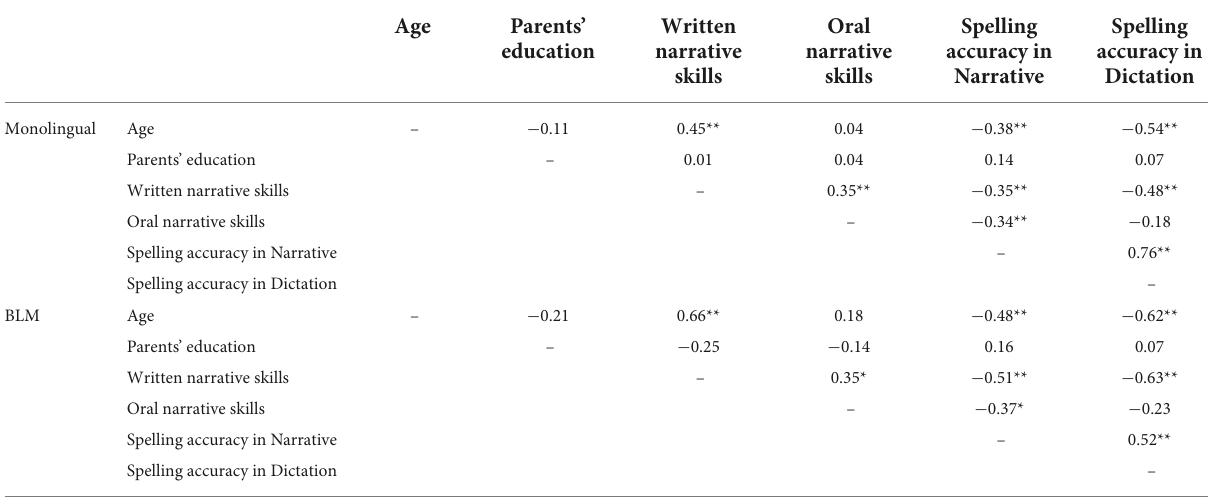
TABLE 3 Correlation